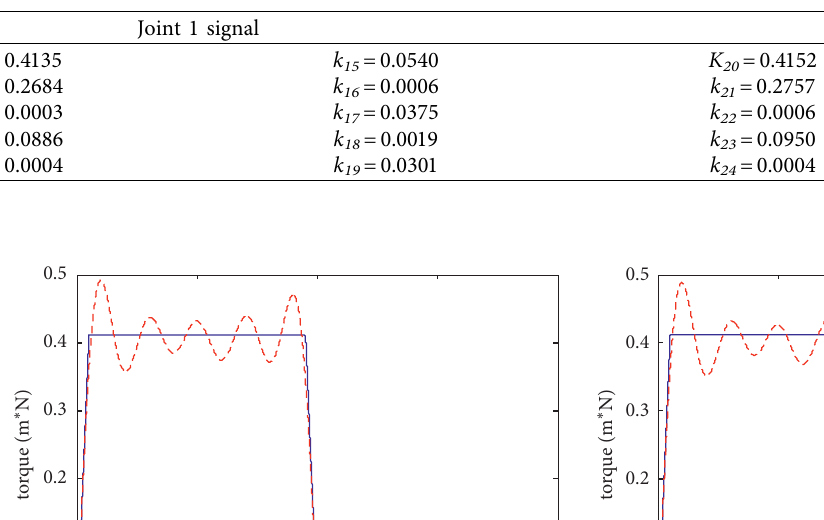
Table 2: Coefficients optimized by the PSO algorithm.